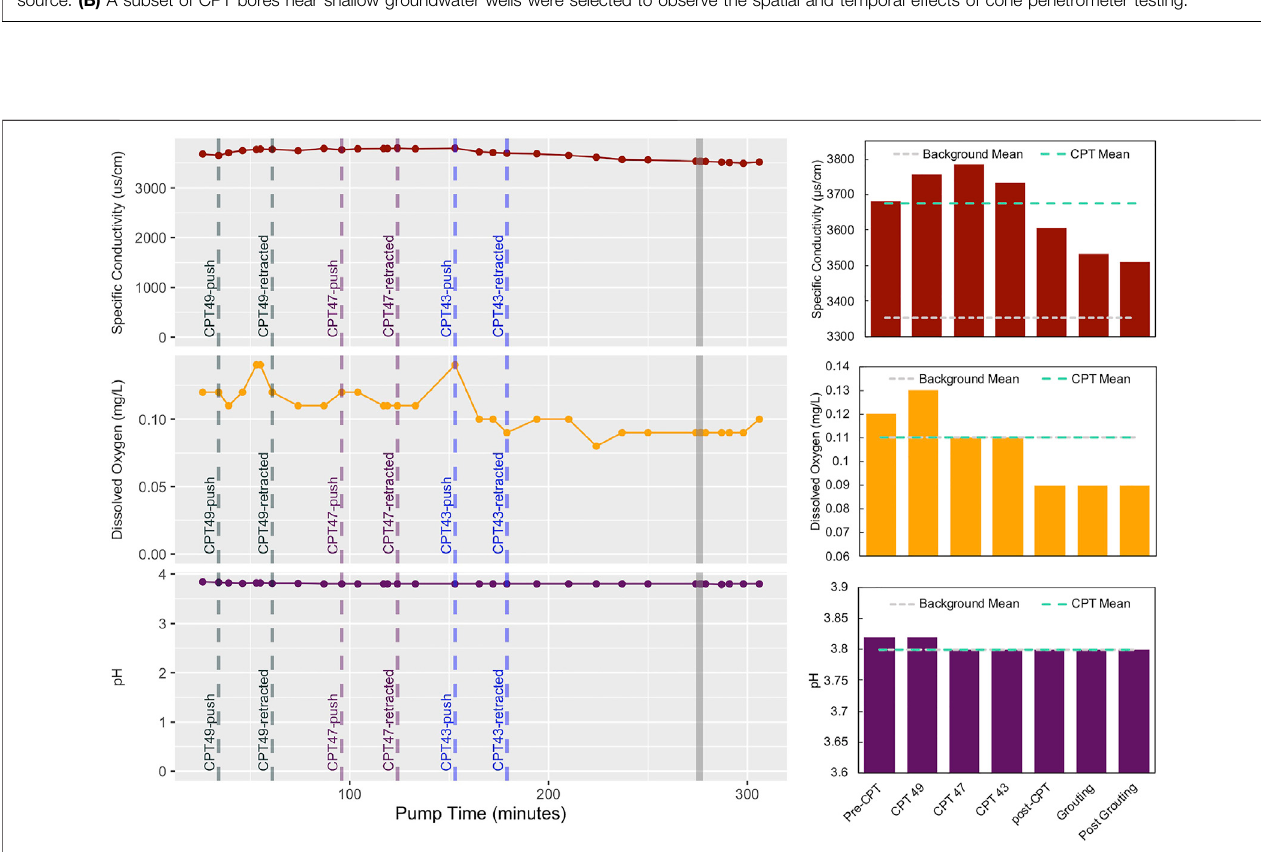
FIGURE 2 | Map of cone penetrometer testing site at the Y-12 complex in Oak Ridge, TN, United States (A) The cone penetrometer study was conducted in the 2,600 square meterArea 3siteat the Y-12complex.Boreholesshown in pinktrianglesformparalleltransects downgradient oftheformer S3waste ponds contaminant source. (B) A subset of CPT bores near shallow groundwater wells were selected to observe the spatial and temporal effects of cone penetrometer testing.